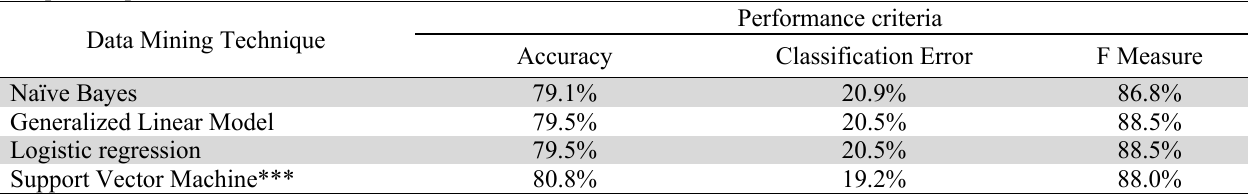
Comparison performance